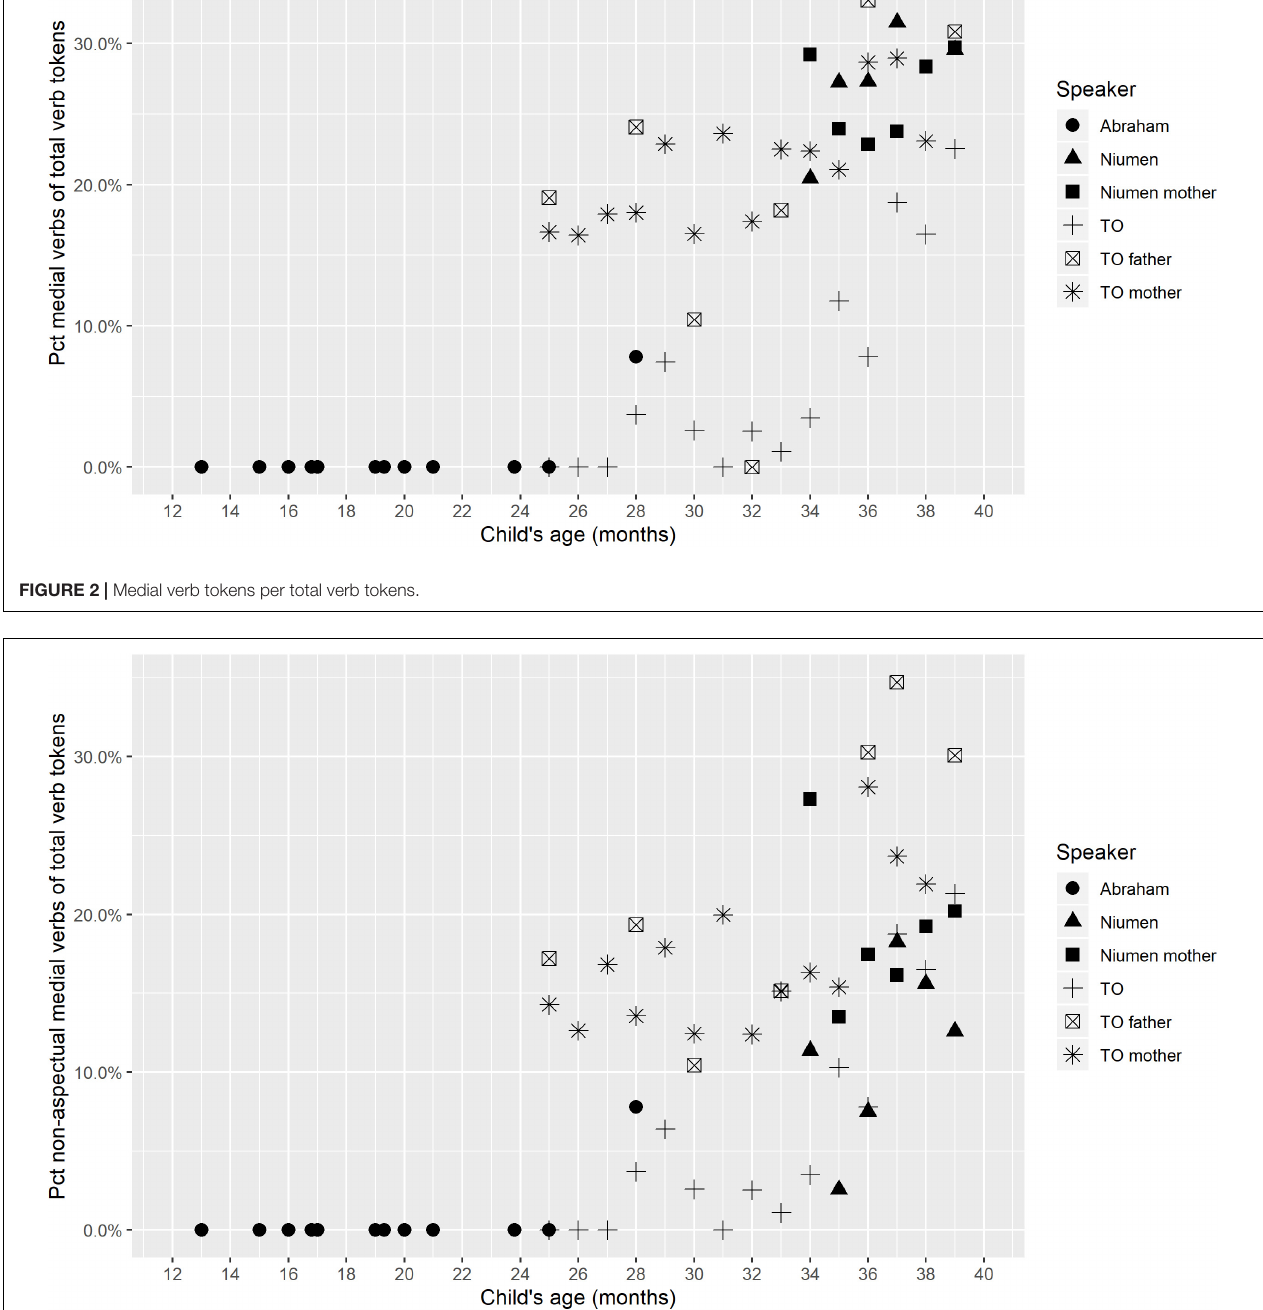
FIGURE 3 | Medial verb tokens not in aspectual constructions, per all verb tokens.